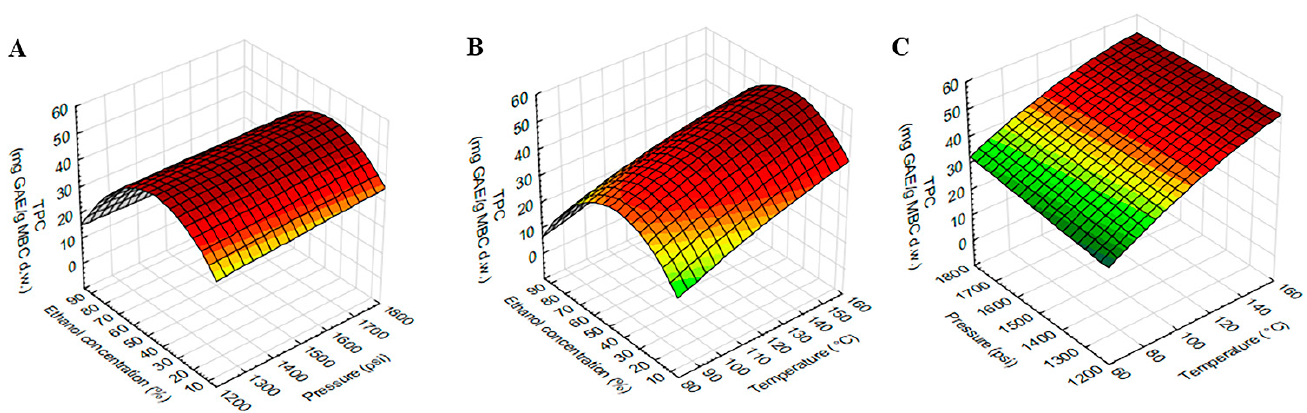
Figure 2. Response surface plots showing the interaction effects of extraction variables on TPC of MBC extract. ( A ) pressure and ethanol concentration at constant temperature (120 ° C), ( B ) temperature and ethanol concentration at constant pressure 1500 psi and ( C ) temperature and pressure at constant ethanol concentration (50%).